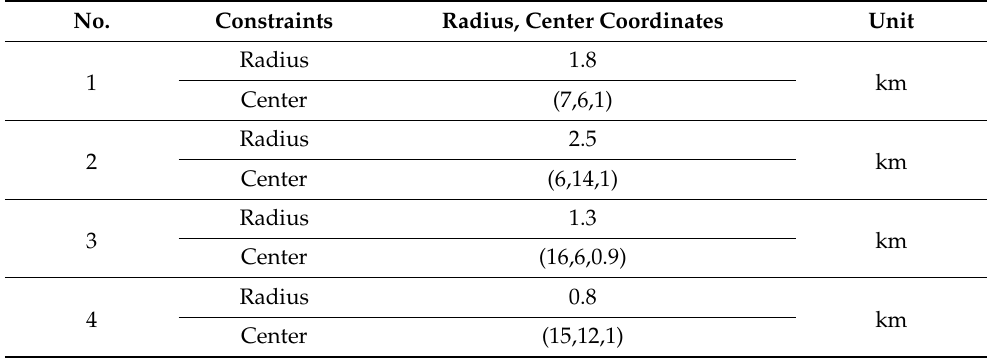
Table 2. Constraints of wind